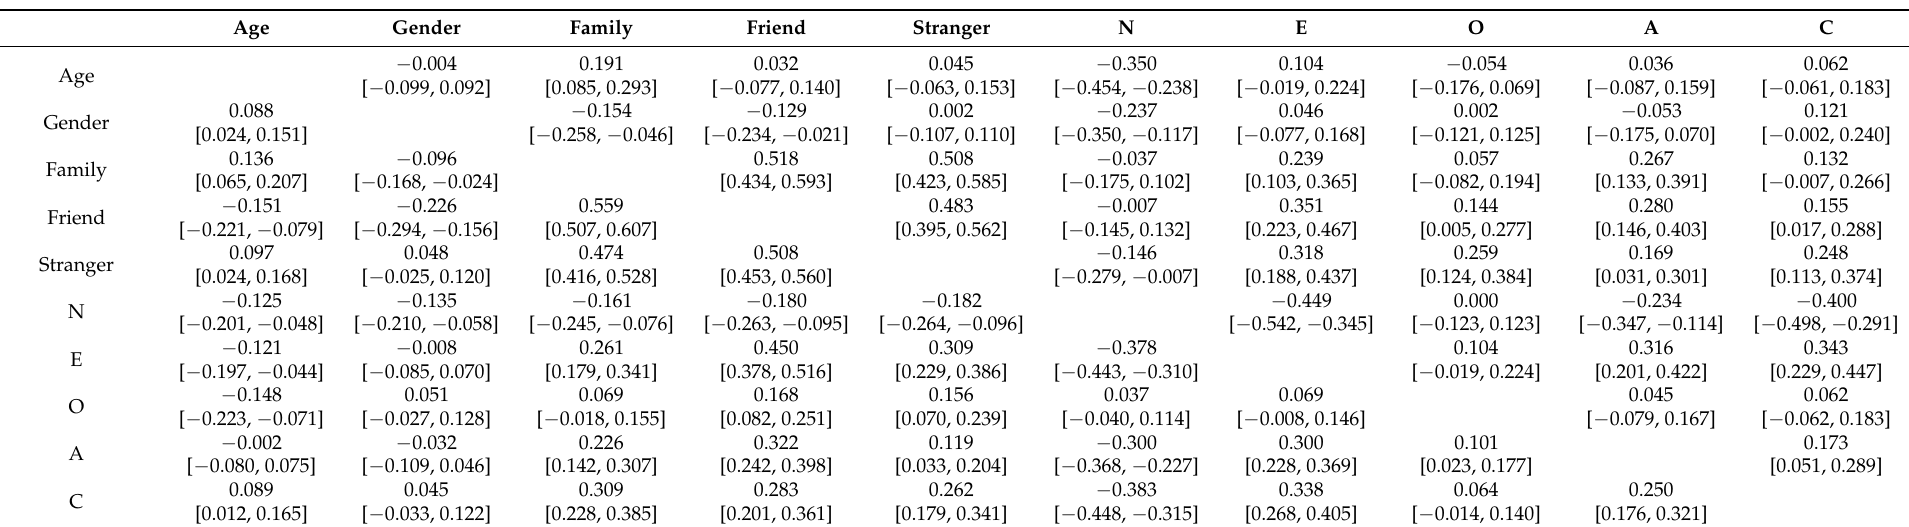
Table 1. Phenotypic correlations among all variables by